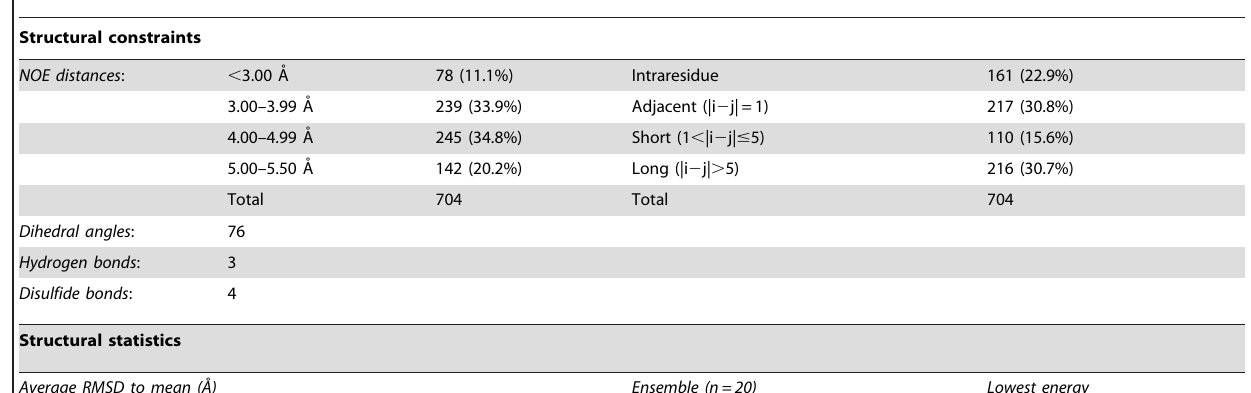
Table 1. Restraints and statistics of the PMF-G structural ensemble.